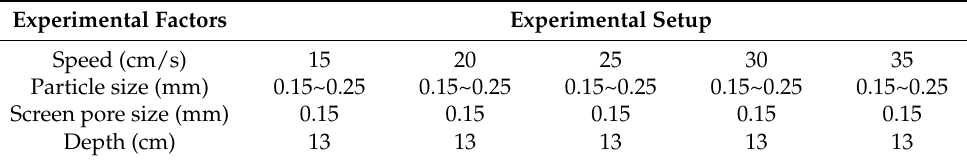
Table 3. Control of experimental conditions.